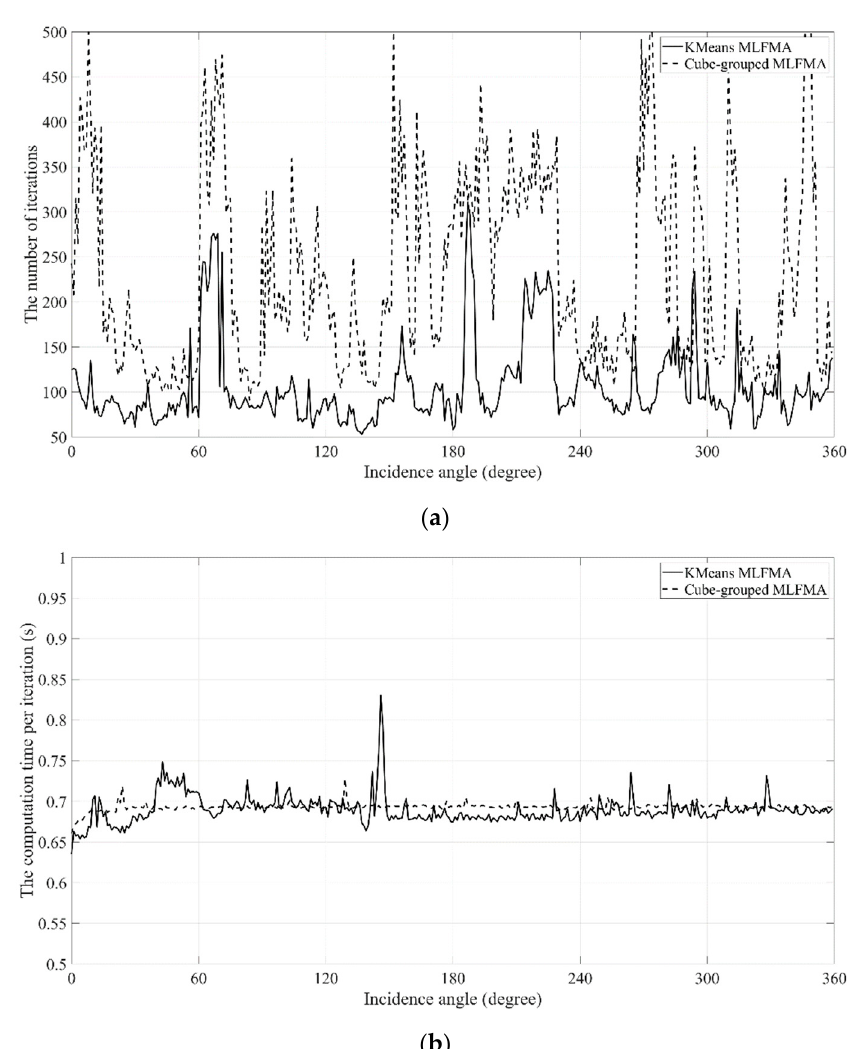
Figure 12. Monostatic RCS results of the realistic stealth CAD model.